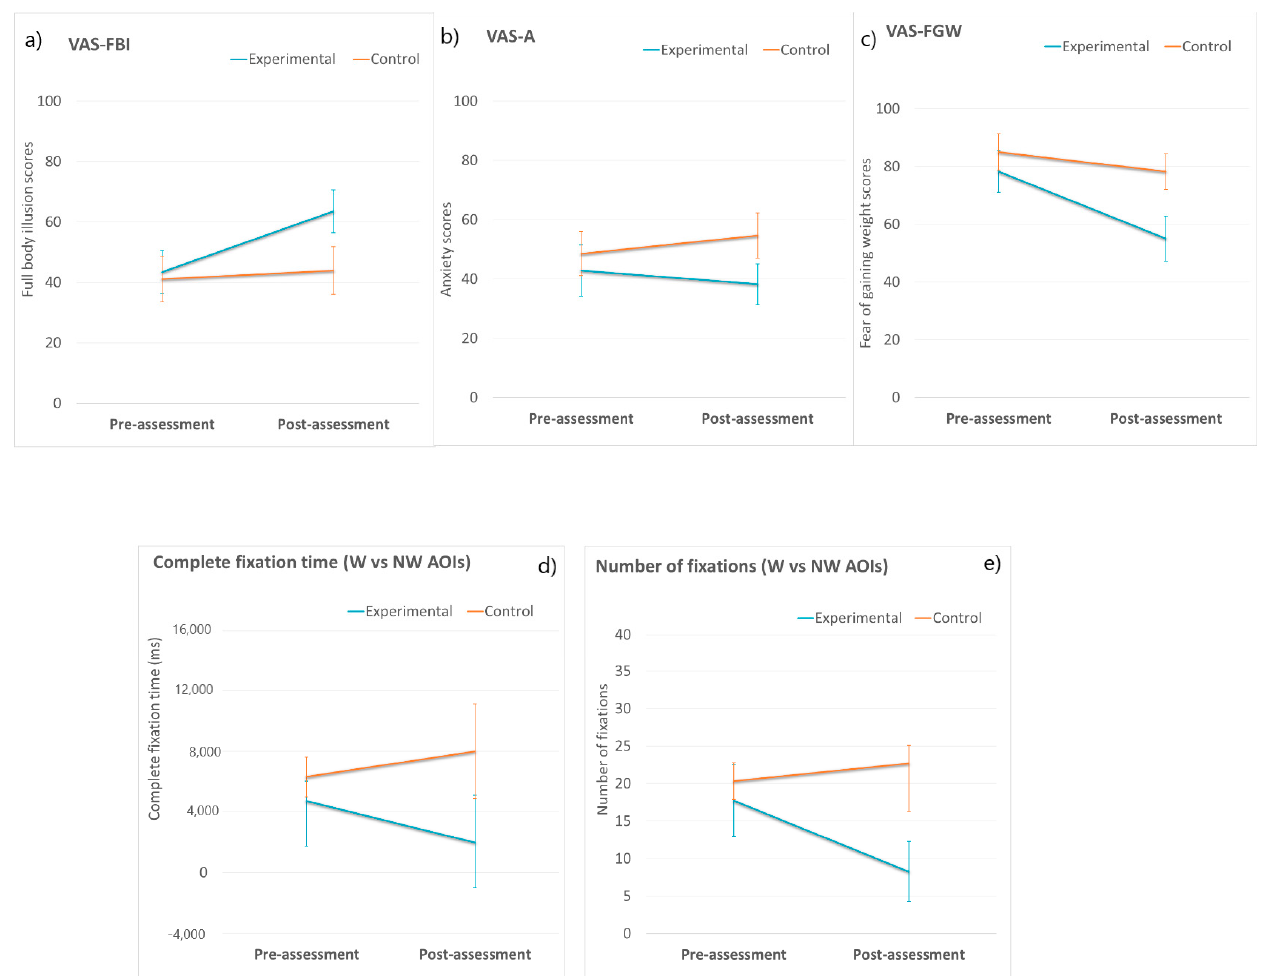
Figure 3. Means of the experimental and control groups in the two assessment conditions (pre-assessment and post-assessment) in Full Body Illusion ( a ), Anxiety ( b ), Fear of Gaining Weight ( c ), Complete fixation Time ( d ) and Number of Fixations ( e ). Error bars represent standard errors of the mean. Note: Visual Analog Scales (VAS), Full Body Illusion (FBI), Anxiety (A), Fear of Gaining Weight (FGW), Weight (W) and Non-Weight (NW) Areas of Interest (AOIs). * p values < 0.05.